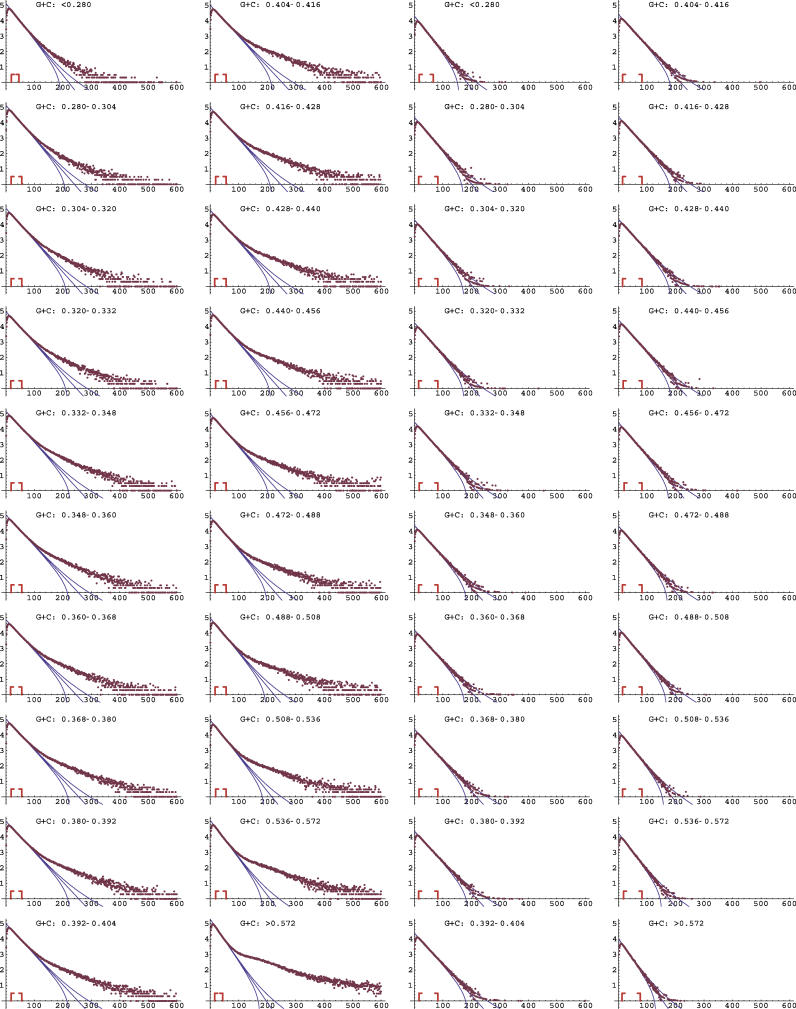
Intergap Distance Distribution by G+C ContentIntergap distance histograms, per G+C content bin, for all of the autosomes and the Y chromosome (Left hand columns) and restricted to ARs within these chromosomes (Right hand columns). Horizontal axes, inter-gap distance (nucleotides); vertical axes, log10 counts. Red anchors denote the segment over which the weighted linear regression was performed to determine the neutral model's indel rate parameter ρ (central blue curve). An overrepresentation of long ungapped segments is apparent in all whole-genome histograms, and especially for higher G+C contents. In contrast, the histograms that include only AR data show a tight fit to the neutral model, with only modest overrepresentation of long segments.